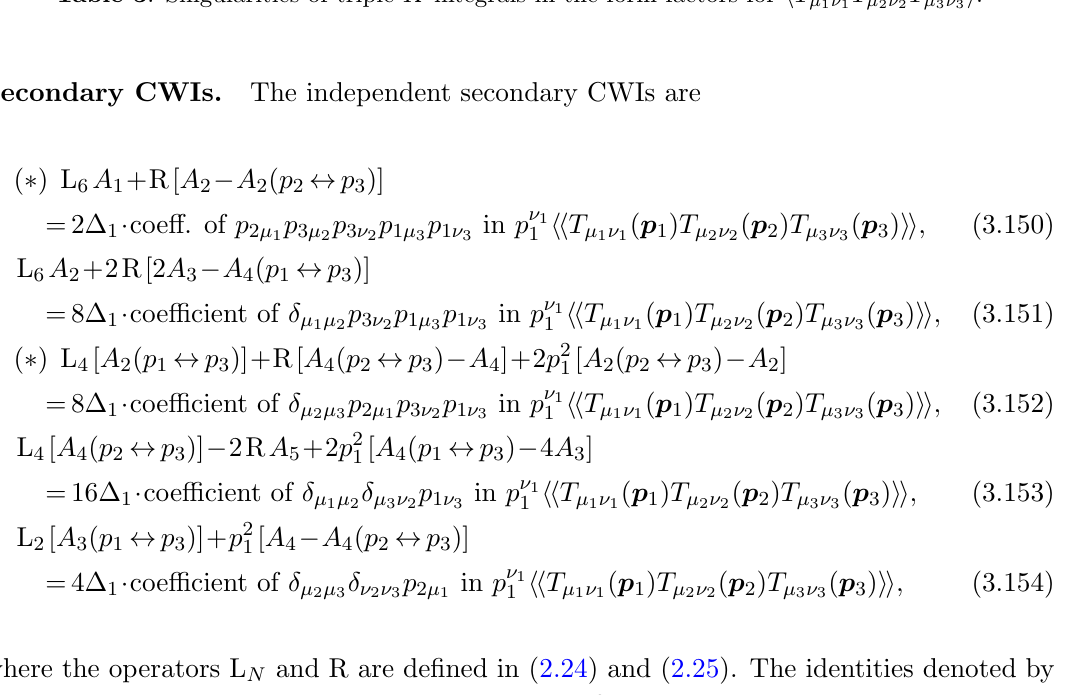
Table 3 . Singularities of triple- K integrals in the form factors for h T (cid:22)